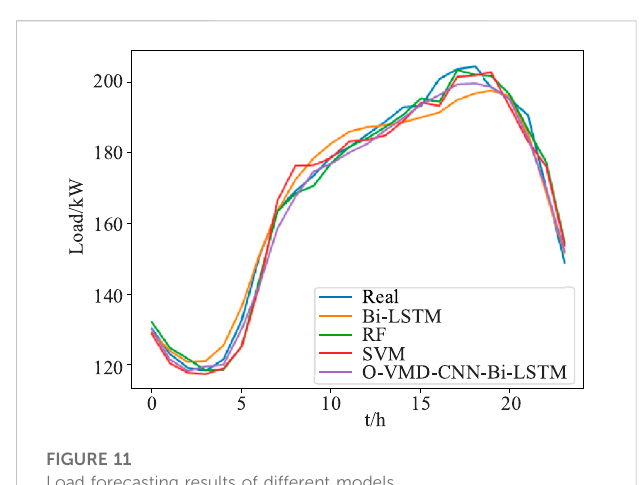
FIGURE 11 Load forecasting results of different